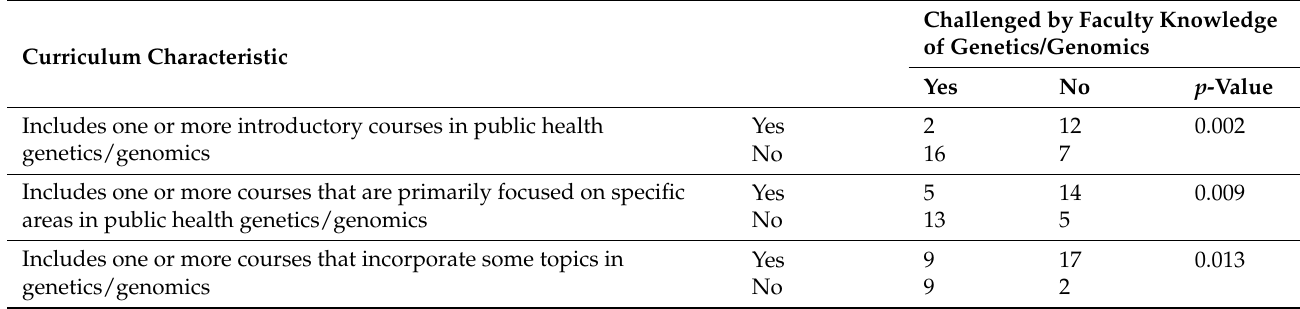
Table 3. Statistically significant barriers to inclusion of genetics in programs.